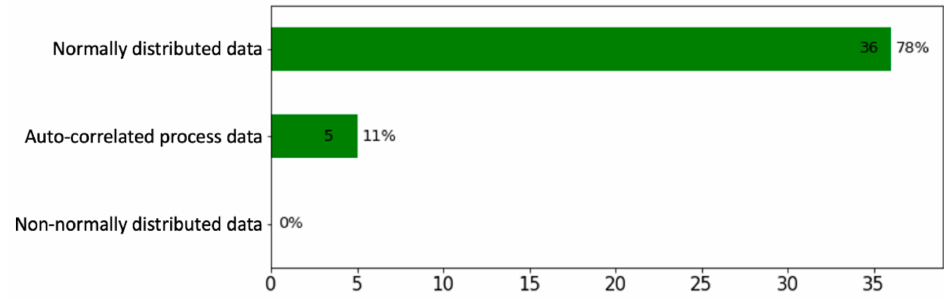
Figure 11. Breakdown of the assumptions of the data